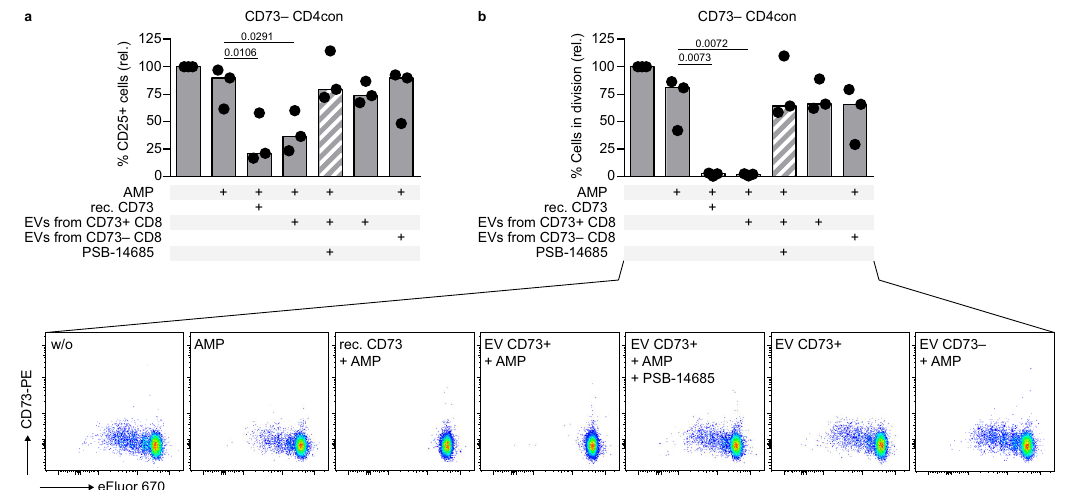
Fig. 5 Extracellular vesicles isolated from the cell culture supernatant of activated CD73 + CD8 T cells are immunosuppressive. CD73 − CD4con T cells were stimulated with α CD3/ α CD28 in the presence of the ADA inhibitor EHNA (10 µ M) and incubated with AMP (50 µ M), recombinant CD73 (15 ng/mL), EVs and PSB-14685 (10 µ M) as indicated. a CD25 expression and b proliferation were measured after 4 days by fl ow cytometry. Data were shown as a median of three donors from independent experiments. For each donor, CD25 expression and proliferation were set in relation to cells only treated with EHNA. Repeated measures one-way ANOVA with Dunnett ’ s multiple comparisons test was used to compare all conditions to cells treated with EHNA and AMP (second bar).